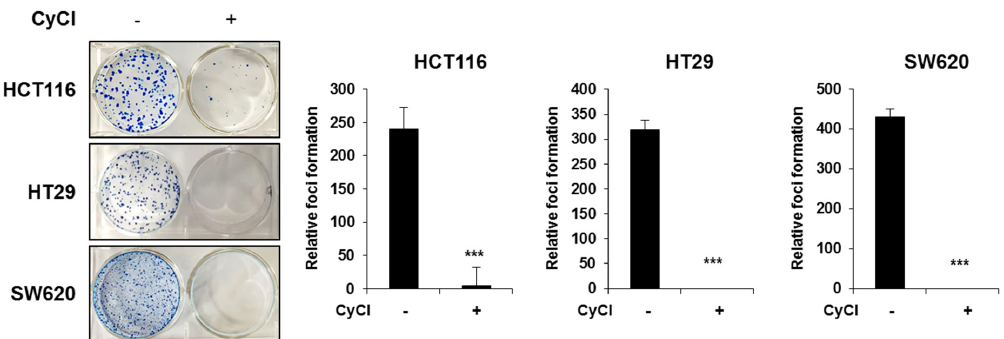
Figure 8. CyCl inhibits colon cancer foci formation. Colony formation assay shows a significant reduction in colony formation in HCT116, HT29, and SW620 cell lines treated with 50 µM of CyCl. Quantitative analyses are given in the form of bar graphs for HCT116, HT29, and SW620 cells, respectively. A dramatic decrease in colony formation is evident from the figure. Statistically significant values are marked with an asterisk. (*** p < 0.001).